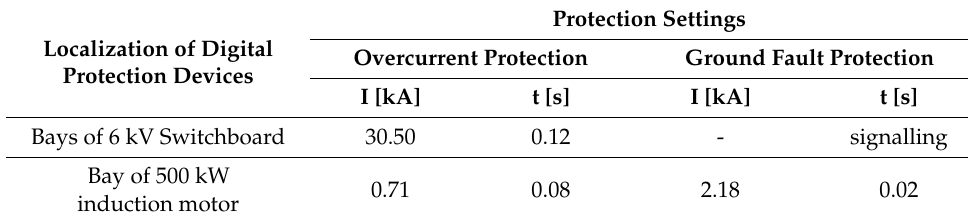
Table 2. Protection settings of digital protection